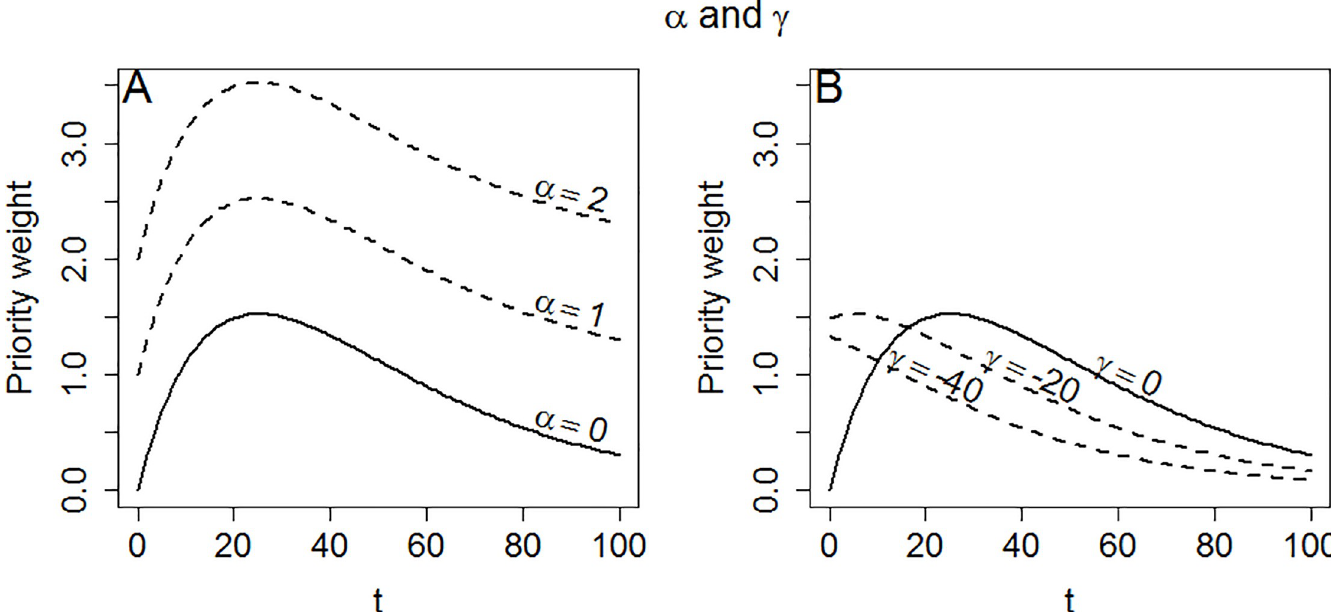
Fig 2. Properties of the coefficients of (5) when C = 0.1658 and β = 0.04. Panel A: Altering α causes an upward or downward shift. Panel B: Altering γ causes a left or right shift. Note that one would typically chose a PW where the maximum weight was at zero.